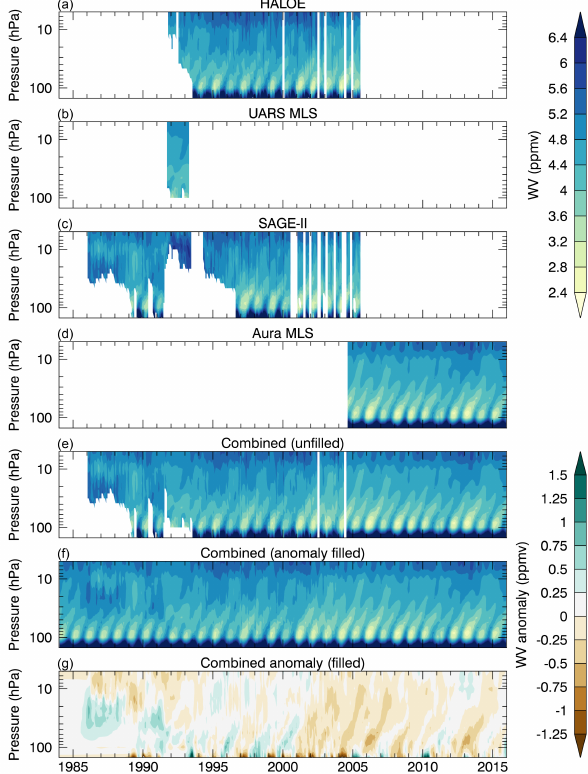
Figure 12. The tropical average (30 ◦ S–30 ◦ N) water vapor con- centration as a function of height and time, which is commonly re- ferred to as the “tropical tape recorder”, for each satellite data set in SWOOSH (a – d) , as well as the two combined products (e – f) and the combined (filled) anomaly product (g) . SAGE III data are non- existent in the tropics and therefore not